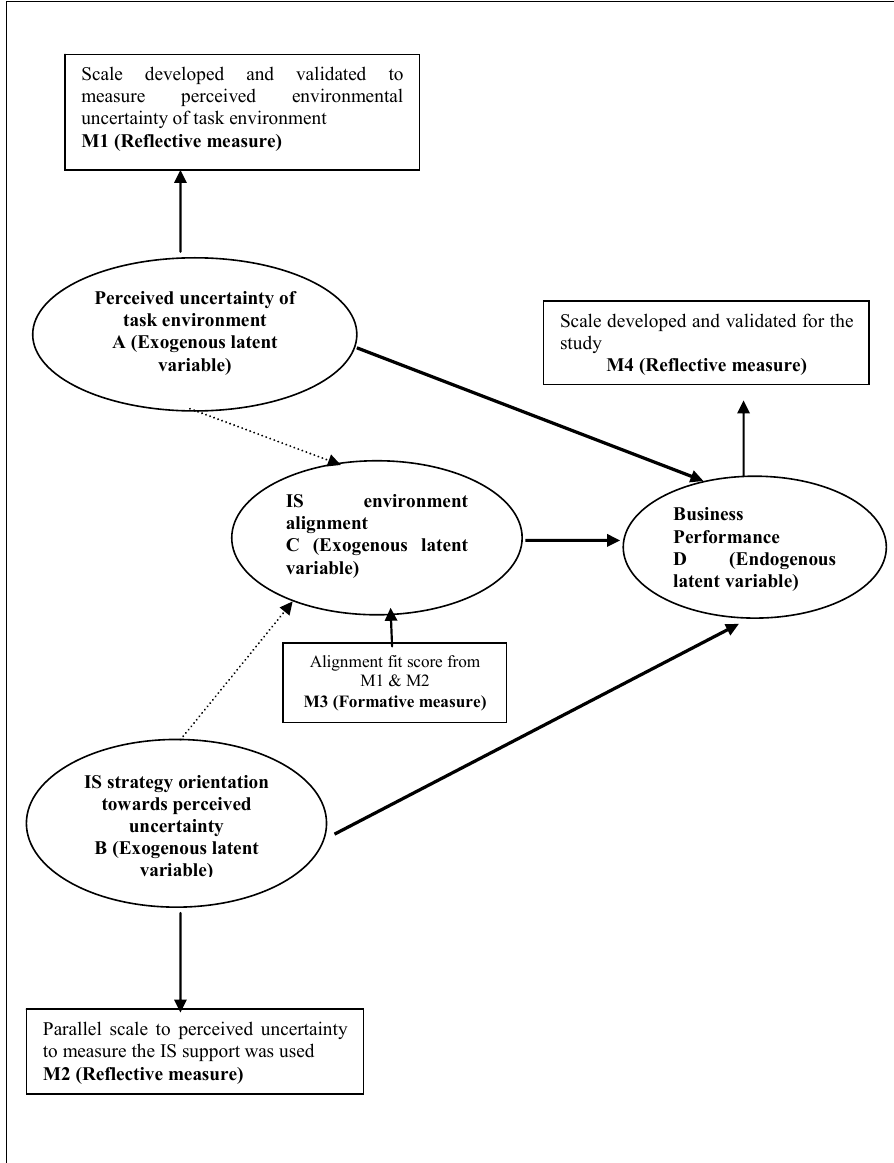
Figure 8: IS environmental alignment model using PLS terminology and showing scales for measuring